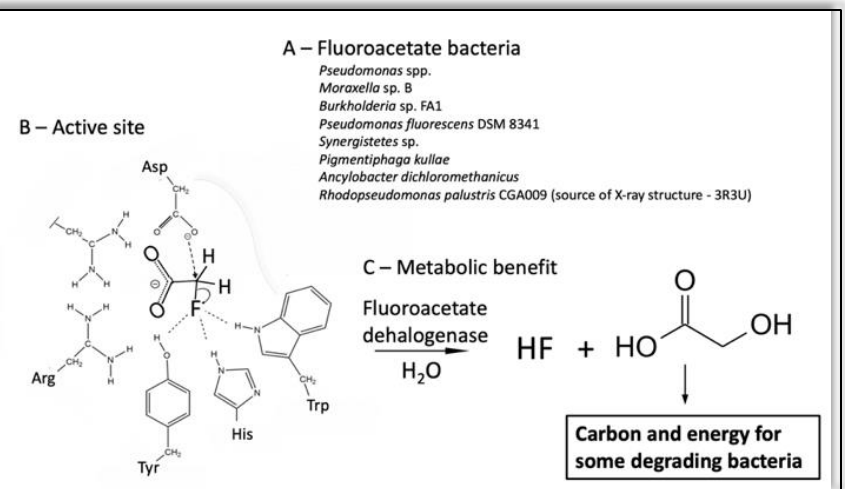
Figure 2. Fluoroacetate metabolism and enzyme from bacteria serves as the main, but rare, example of direct C–F bond cleavage. ( A ) Bacteria catalyzing defluorination of fluoroacetate. ( B ) Active site of the fluoroacetate dehalogenase from Rhodospeudomonas palustris CGA009 (3R3U). ( C ) Metabolic benefit. In addition to detoxification, some bacteria can use hydroxyacetic acid, or glycollate, as a sole source of carbon and energy to support growth.